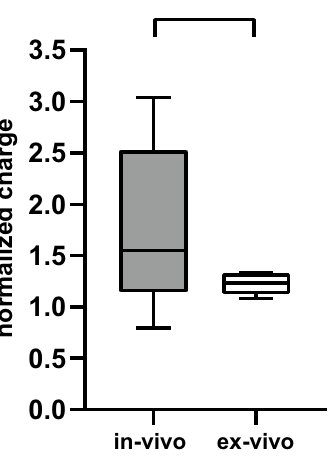
Figure 7. Comparison of the normalized charges required to reduce heart rate by 10 bpm ex-vivo versus in-vivo. Data represent the mean values from five experiments in-vivo ex-vivo, and six experiments ex-vivo. Data are presented as mean and standard deviation